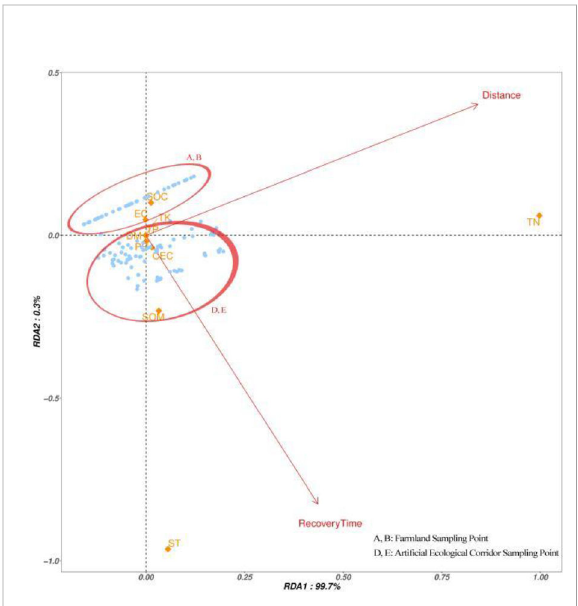
FIGURE 5 Cultivated land within 300 m from the ecological corridor and all collected samples in the ecological